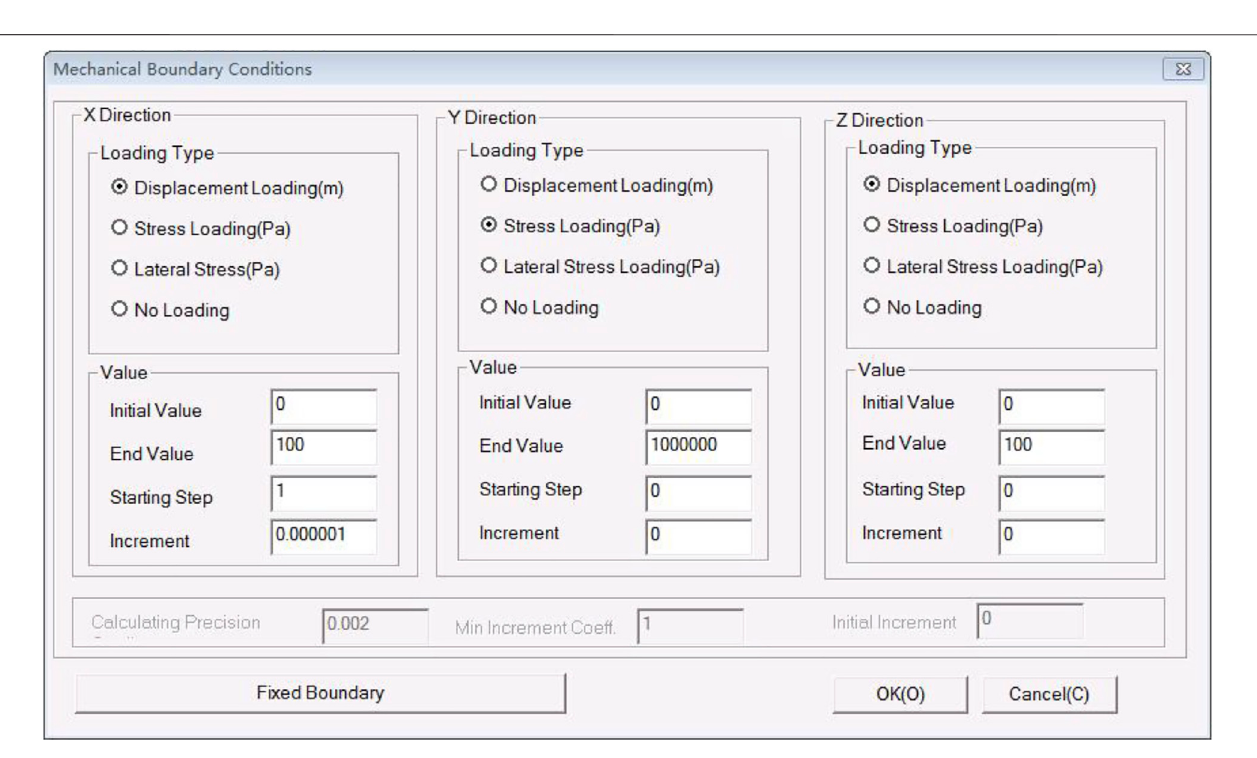
Frontiers in Earth Science |